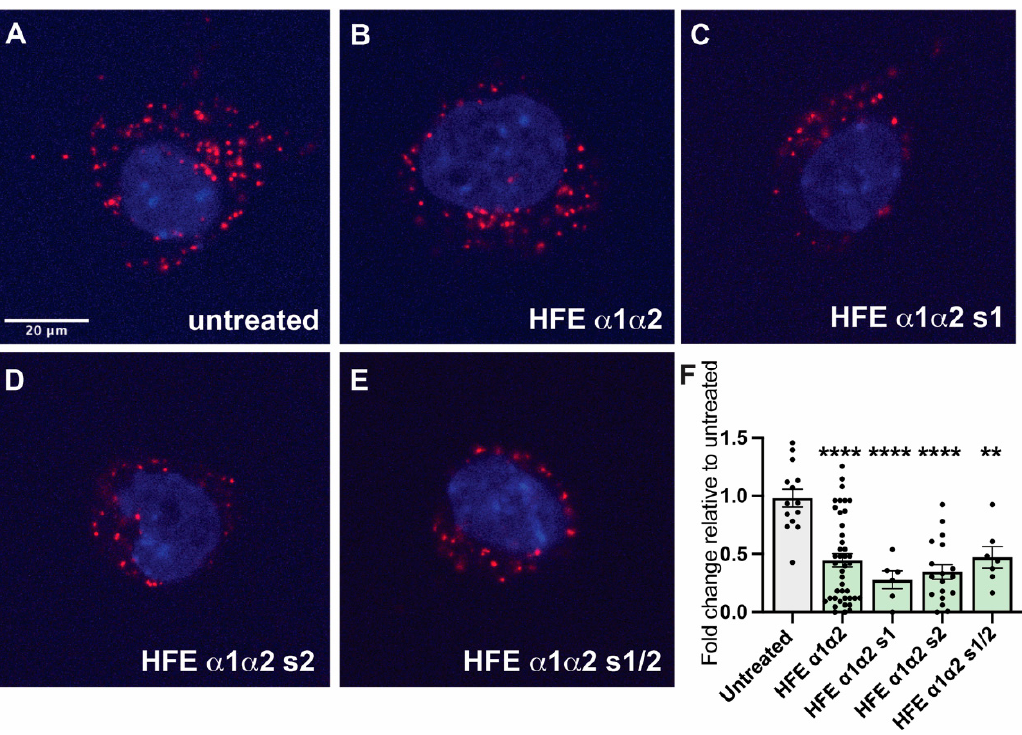
Figure 5. Imaging and quantification of the proximity ligation assay of the HFE α 1 α 2 stapled peptides. Mouse liver Hepa 1–6 cells were seeded and treated with peptides (50 µ M final concentration) overnight, after which they were washed, fixed, and stained according to the Duolink ® kit instructions. Images were acquired using either a Zeiss 780 NLO, a Leica TCS SP5 or a spinning disk confocal microscope (Diskovery, Andor technology, UK) on a Nikon Ti-E body with a Andor iXon888 EMCCD camera. Total number of protein–protein interactions per cell was quantified using the “Find Maxima” function of FIJI. ( A ) Untreated cells; ( B ) HFE α 1 α 2; ( C – E ) HFE α 1 α 2-s1, HFE α 1 α 2-s2 and HFE α 1 α 2-s1/s2, respectively. The sharply bright red spots correspond to TFR1/HFE complexes. ( F ) Bar scatter plot showing quantification of the proximity ligation assay. All stapled derivatives reduced the number of HFE–TFR1 complexes found per cell with respect to untreated cells but were not significantly different to the unstapled HFE α 1 α 2 peptide. (n ≥ 6. One-way ANOVA with Tukey’s test, **** p < 0.0001, ** p < 0.002).